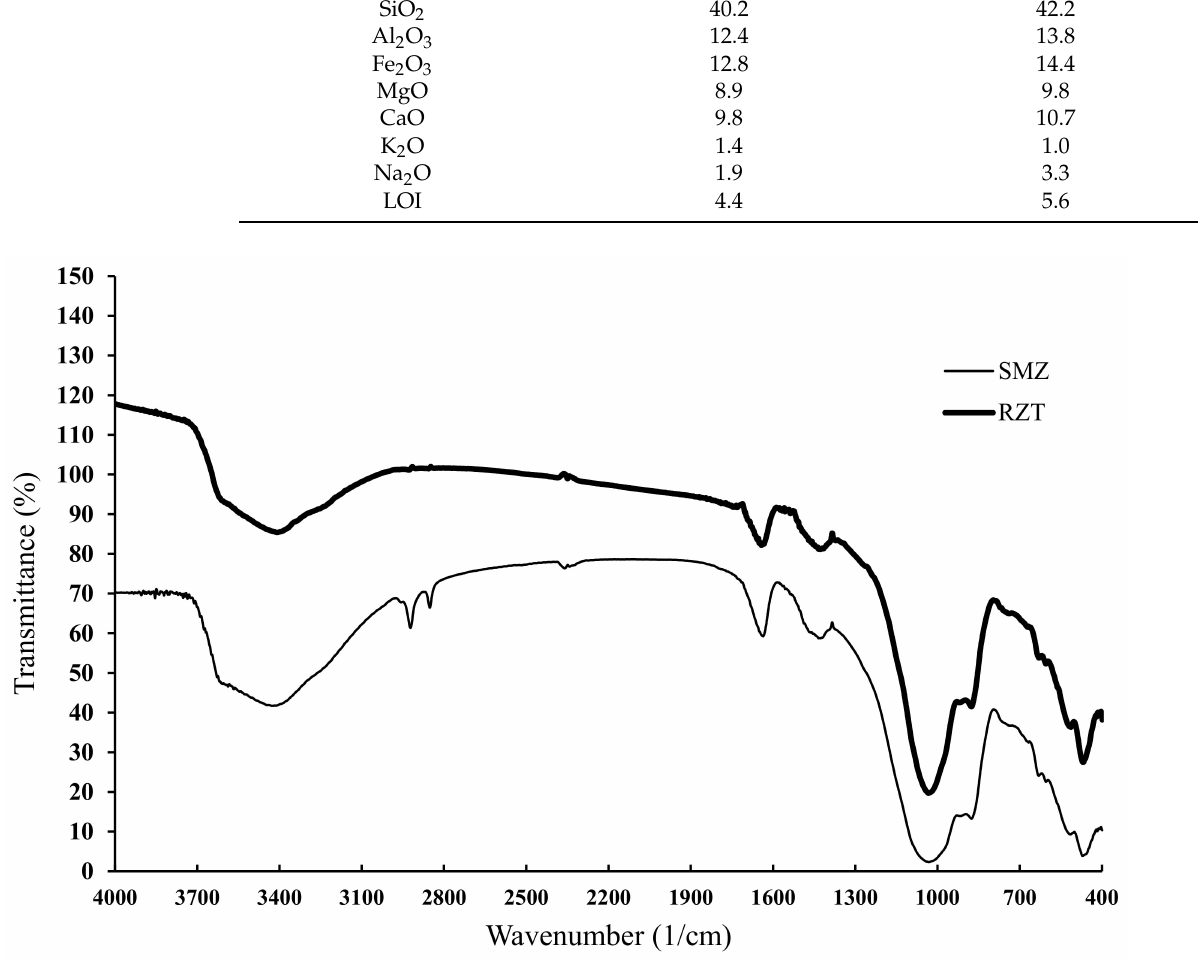
Figure 3. FTIR spectroscopy for the structure of the RZT and